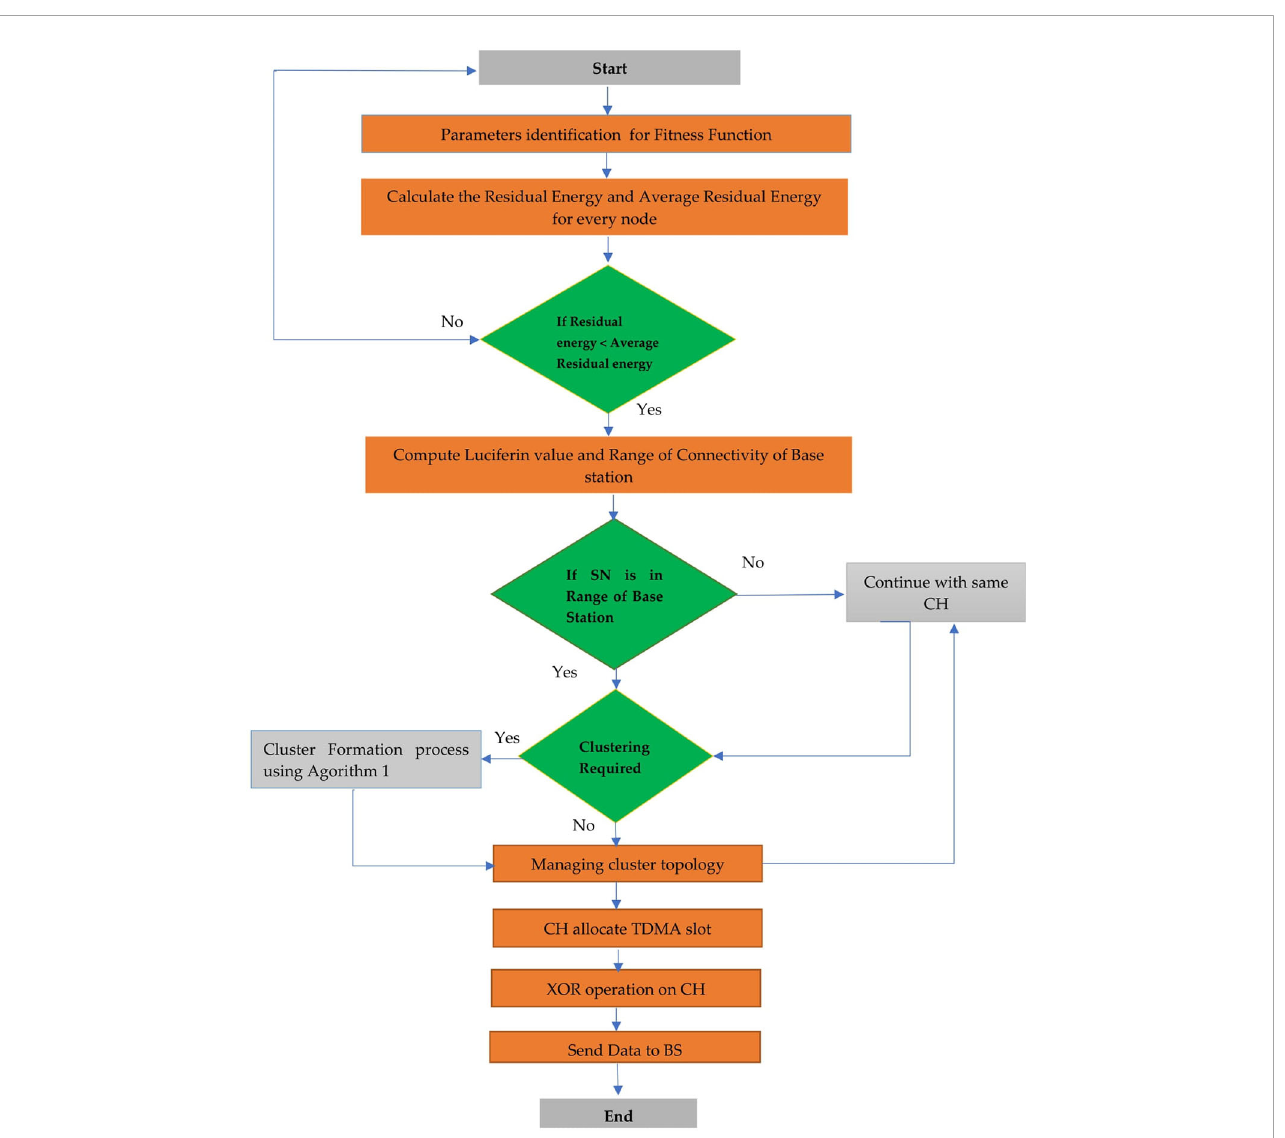
FIGURE 3 Flowchart for proposed